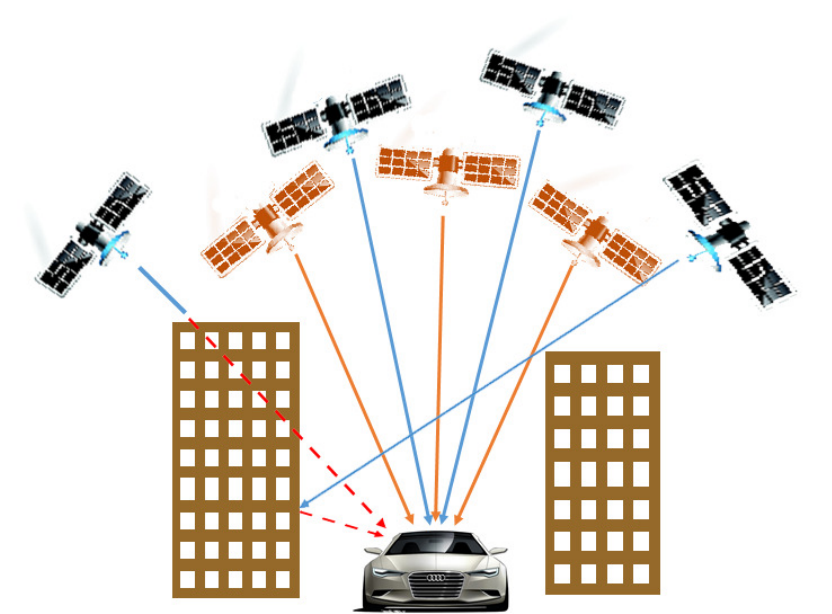
Figure 6. Positioning with GPS and BDS under bad conditions.